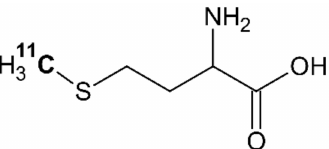
Figure 2. The chemical structure of [ 11 C]methionine, redrawn from